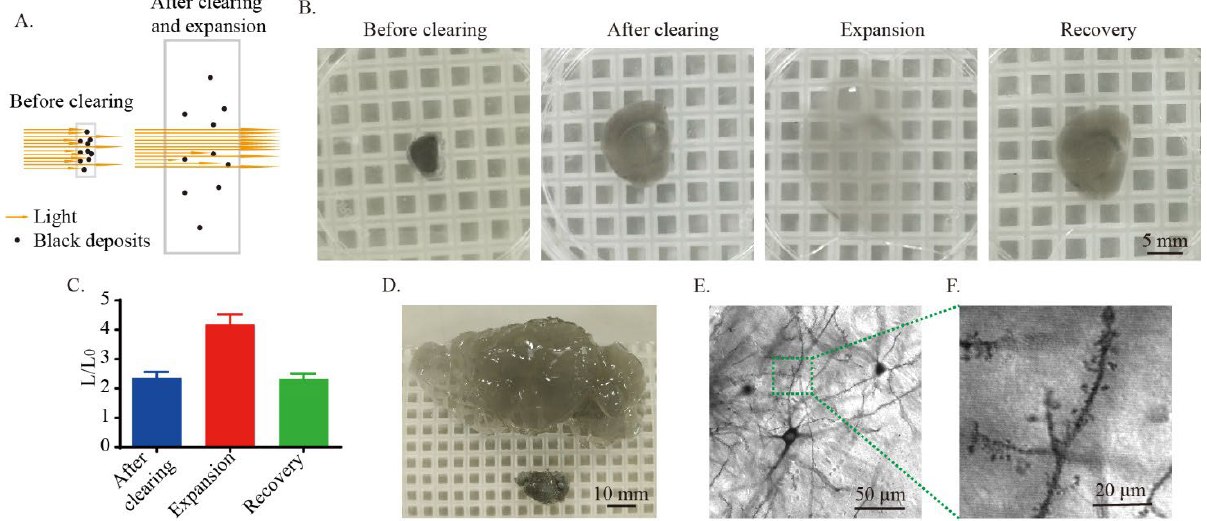
Figure 1. Rapid clearing of Golgi-Cox-stained tissue. ( A ) Schematic diagram showing that expansion of the Golgi-Cox-stained tissue increased light transmission. ( B ) Representative photos showing clearing, expansion, and recovery of 1 mm thick Golgi-Cox-stained tissue. The cleared samples were incubated in DI water for expansion. Otherwise, the samples were incubated in PBS. The 1 mm thick slices were cleared in the clearing solution for 6 h at 70 °C. ( C ) Statistics of the linear expansion of Golgi-stained tissue during clearing, expansion, and recovery. The histogram is shown as the mean ± SEM (n = 6). ( D ) Expansion of Golgi-Cox-stained hemibrain of mice and the cleared tissue was expended in DI water. The hemibrain was cleared in the clearing solution for 24 h at 70 °C. ( E ) The neuronal cell bodies and fibers after clearing and expansion. The image was taken using transmitted light with confocal microscopy. ( F ) The dendritic spines after clearing and expansion. The image was taken using transmitted light with confocal